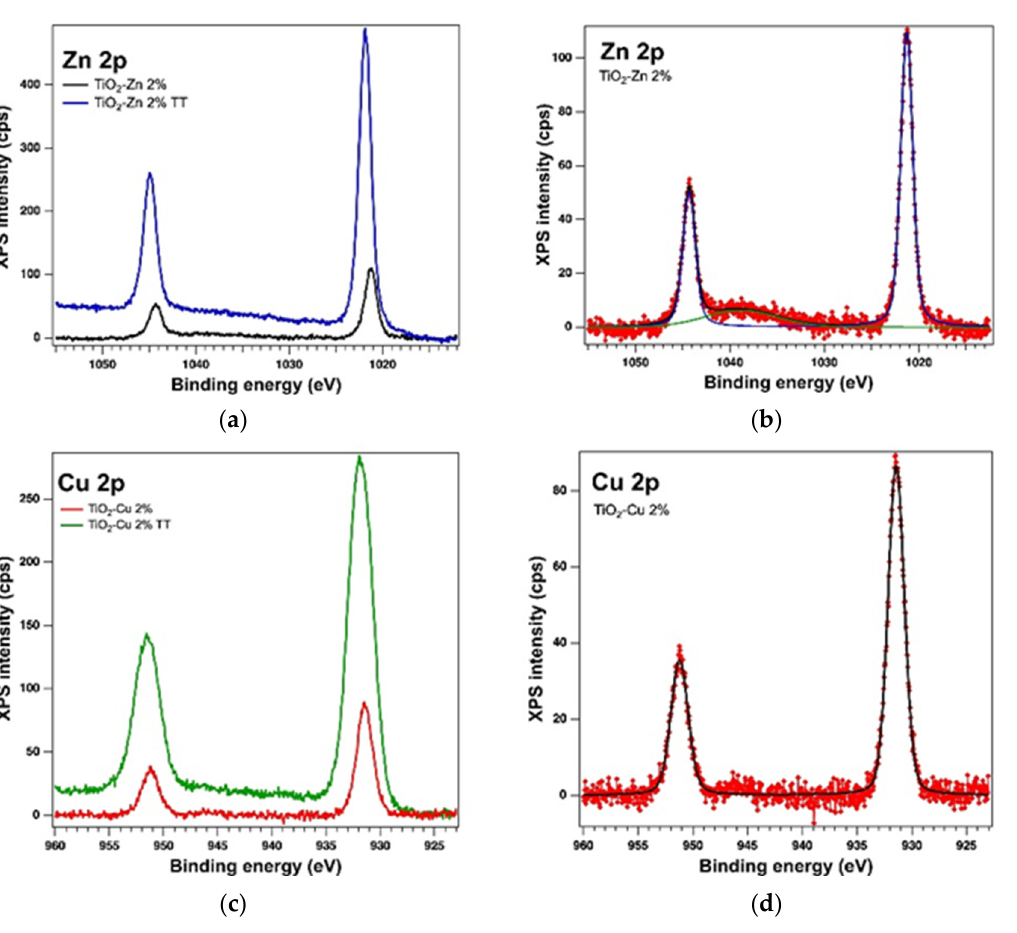
Figure 7. XPS spectra of the core levels Zn 2p ( a ) and Cu 2p ( c ) overlayed XPS spectra of both kinds of samples and the experimental data (red symbols) with the fit and deconvolutions for ( b ) the sol − gel sample with Zn (deconvolutions: components C1–blue line and C2–green line) and ( d ) the sol − gel sample with Cu (only one component–black line).